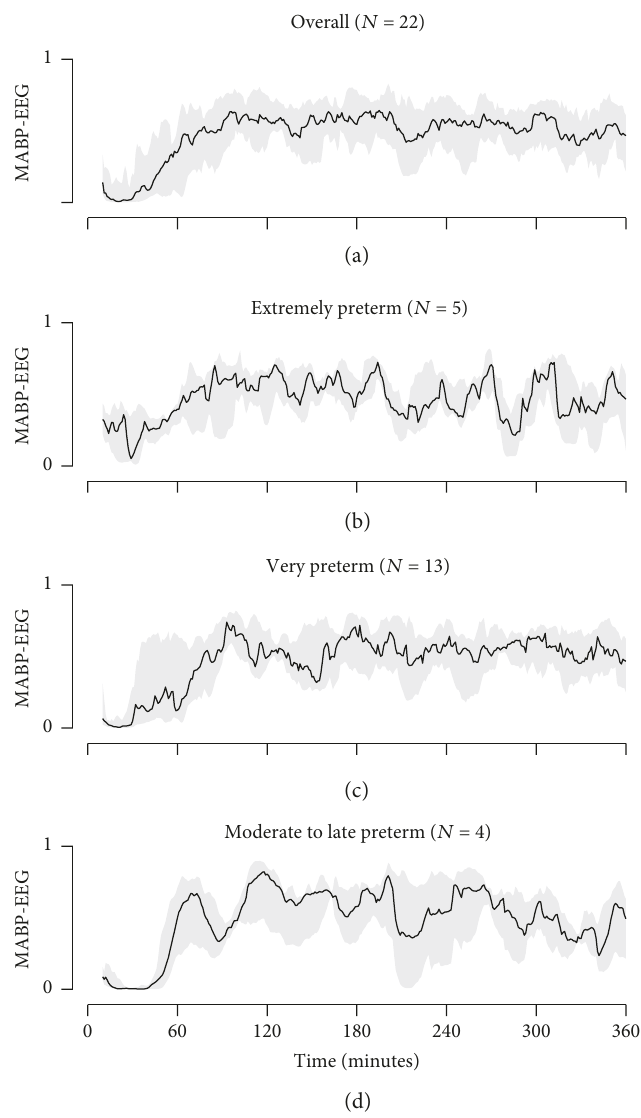
Figure 6: Signal interaction between MABP and EEG after administration of propofol at t =0 minutes. The signal interaction was computed using k T x i , x j . A reduction in interaction is observed among the di ff erent signal modalities after the administration of propofol, with a slow recovery to the reference level. The black line and gray shaded area present the median and interquartile range (IQR),